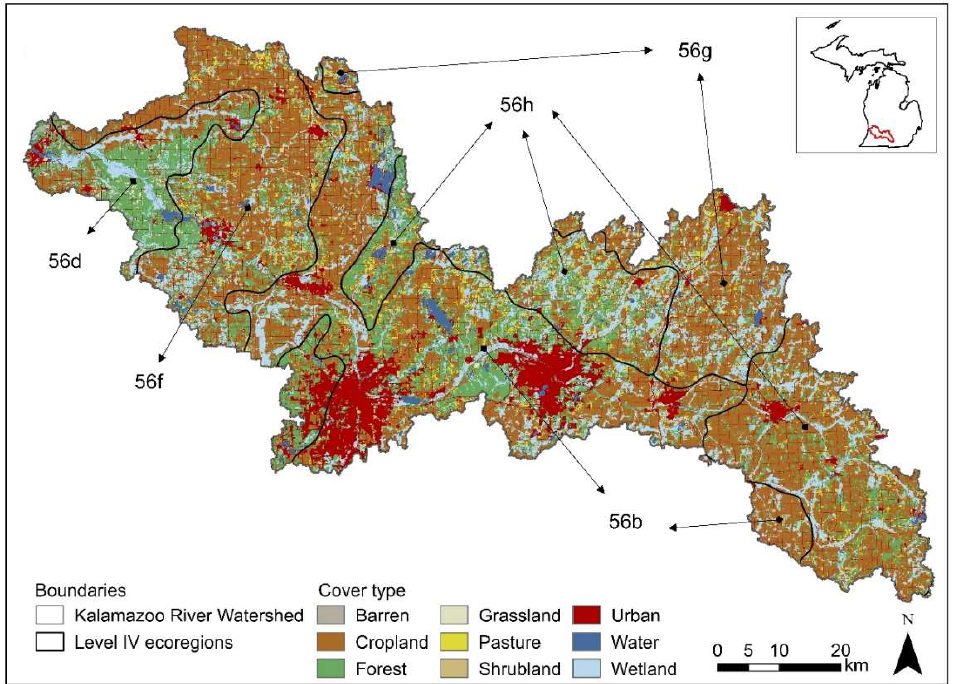
Figure 1. The study area of the five United States Environmental Protection Agency Level IV ecoregions and the nine National Land Cover Database cover type classes within the Kalamazoo River Watershed in 2001. (Map projection: WGS-84 UTM Zone 16 N).